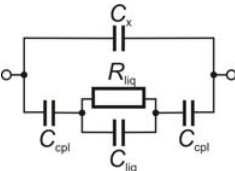
Figure 1. A simplified scheme of the equivalent electric circuit for the contactless impedance cell with connections to the input high-frequency voltage source and the output signal meter. For discussion and symbols explanation see the